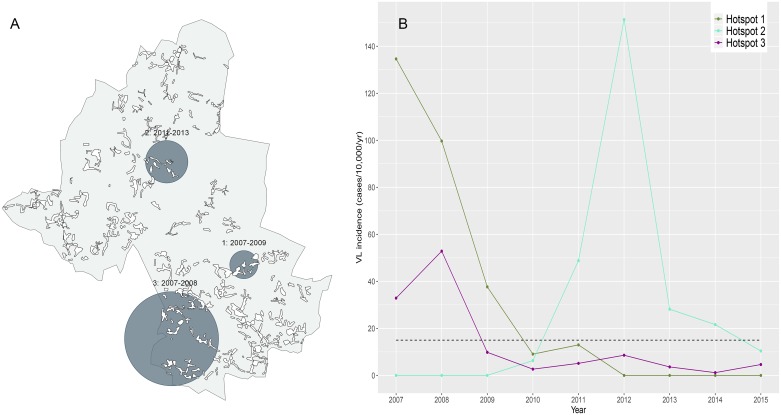
Spatiotemporal hotspots of visceral leishmaniasis (VL) within the study area in Muzaffarpur, Bihar, India shown spatially (dark grey circles, panel A) and over time (panel B).The black dashed line in panel B represents the cut-off value for an ‘outbreak’, where at least three annual cases are detected within a hotspot (VL incidence of ≥15 cases per 10,000 per year).